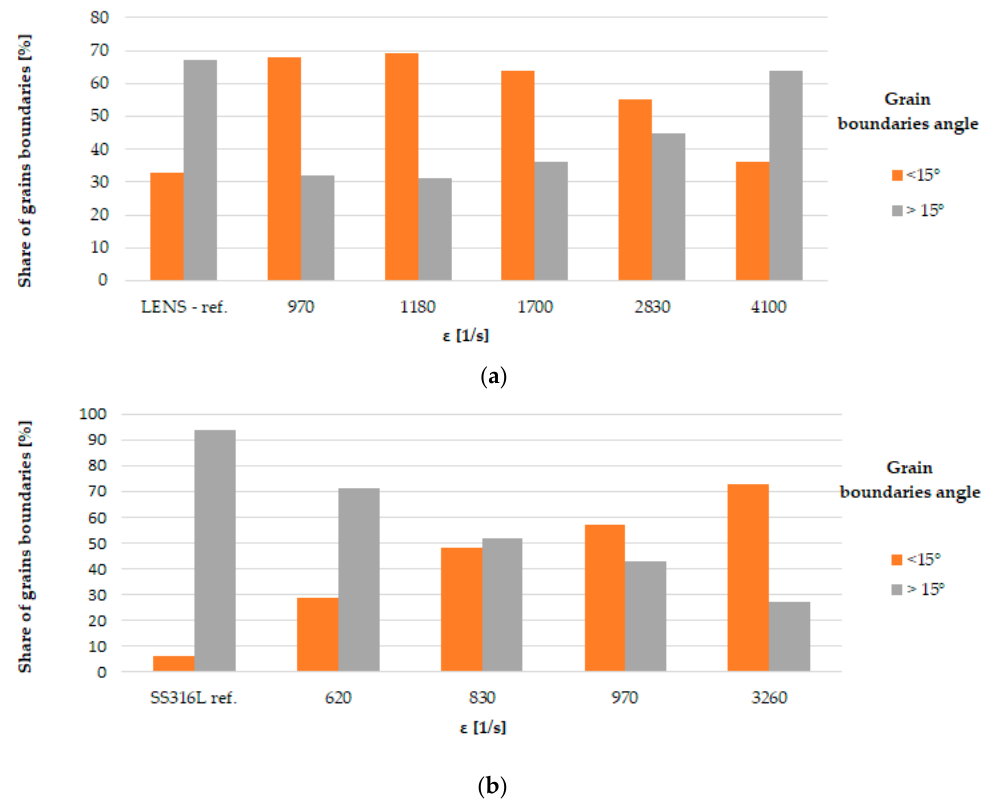
Figure 7. Distribution of the share of low and high angles for the 316L steel samples subjected to dynamic plastic deformation: ( a ) manufactured with the LENS method; ( b ) manufactured with the hot forging method.